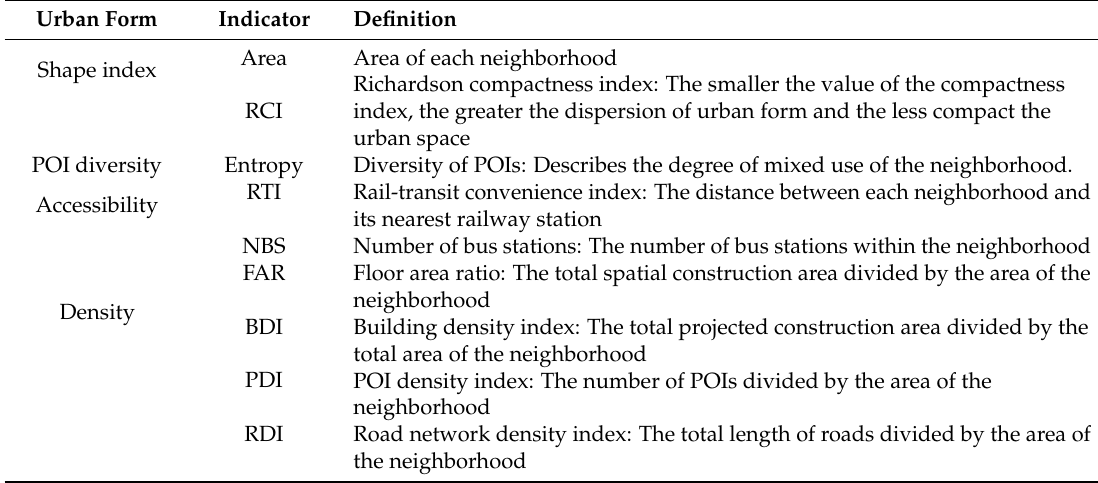
Table 2. Definitions of urban form indicators.